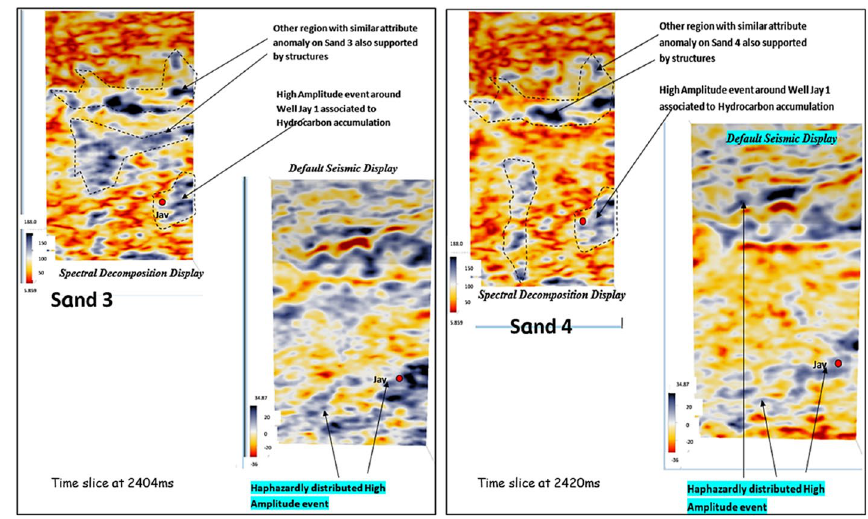
Fig. 19 Default seismic and spectral decomposition attributes of sand 3 and sand 4